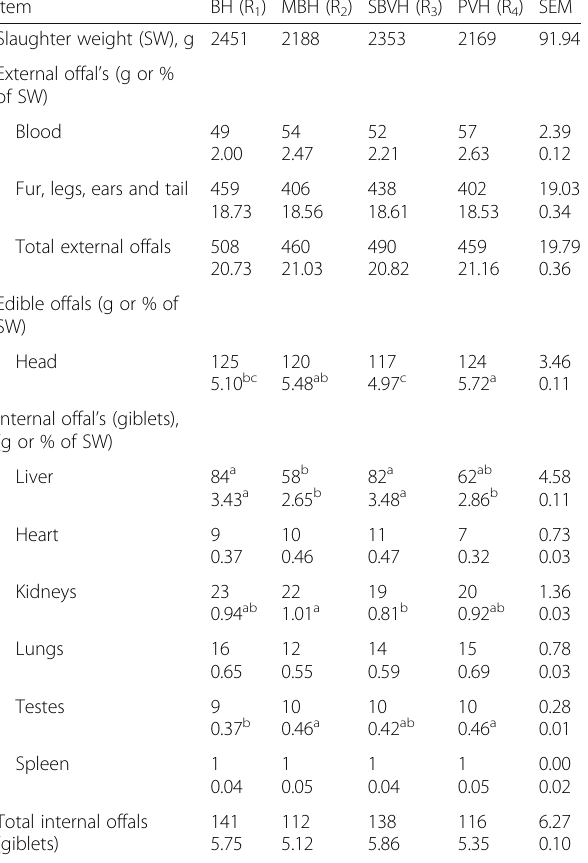
Table 6 External and internal offal ’ s (Giblets) of the experimental groups